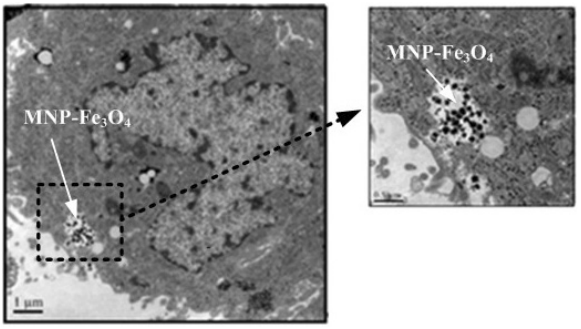
Fig. 4. TEM image of MNP – Fe 3 O 4 internalized HepG2